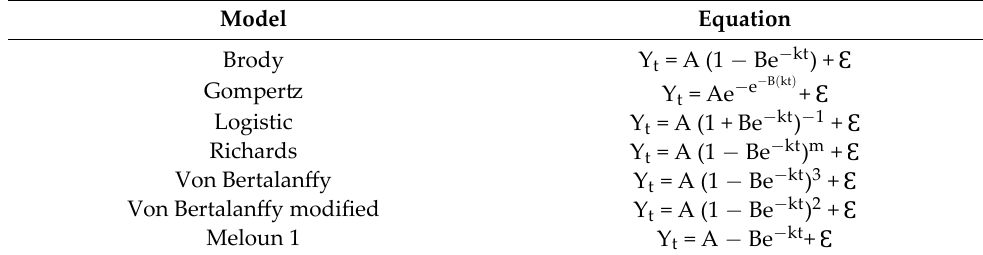
Table 1. Nonlinear regression models used to describe growth curves.